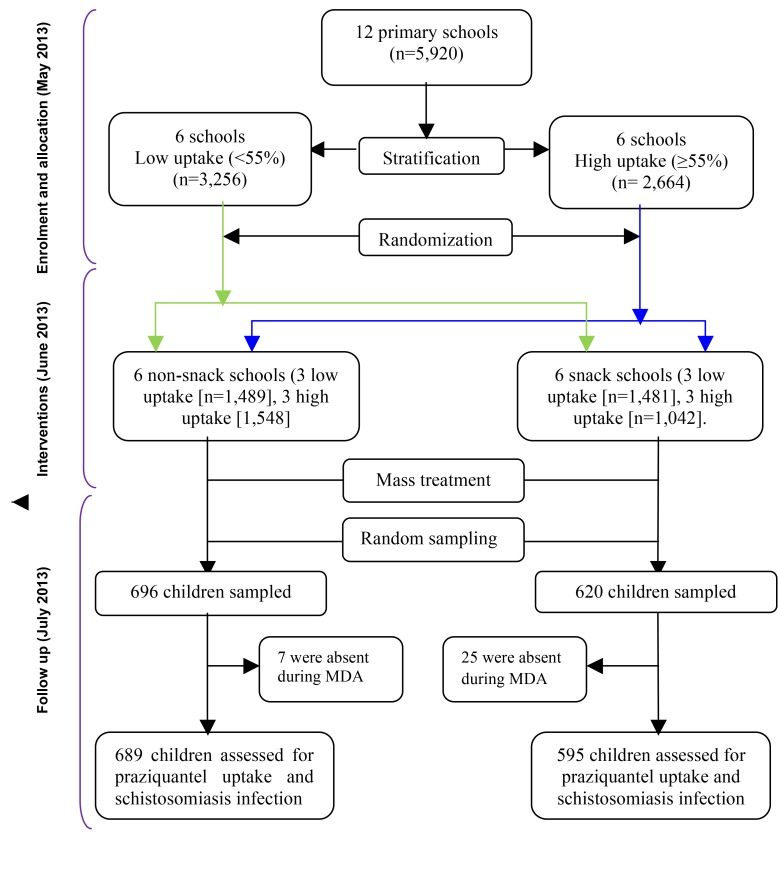
Study profile showing stratification and randomization of the schools to the intervention groups and the selection of children for assessment after mass treatment.